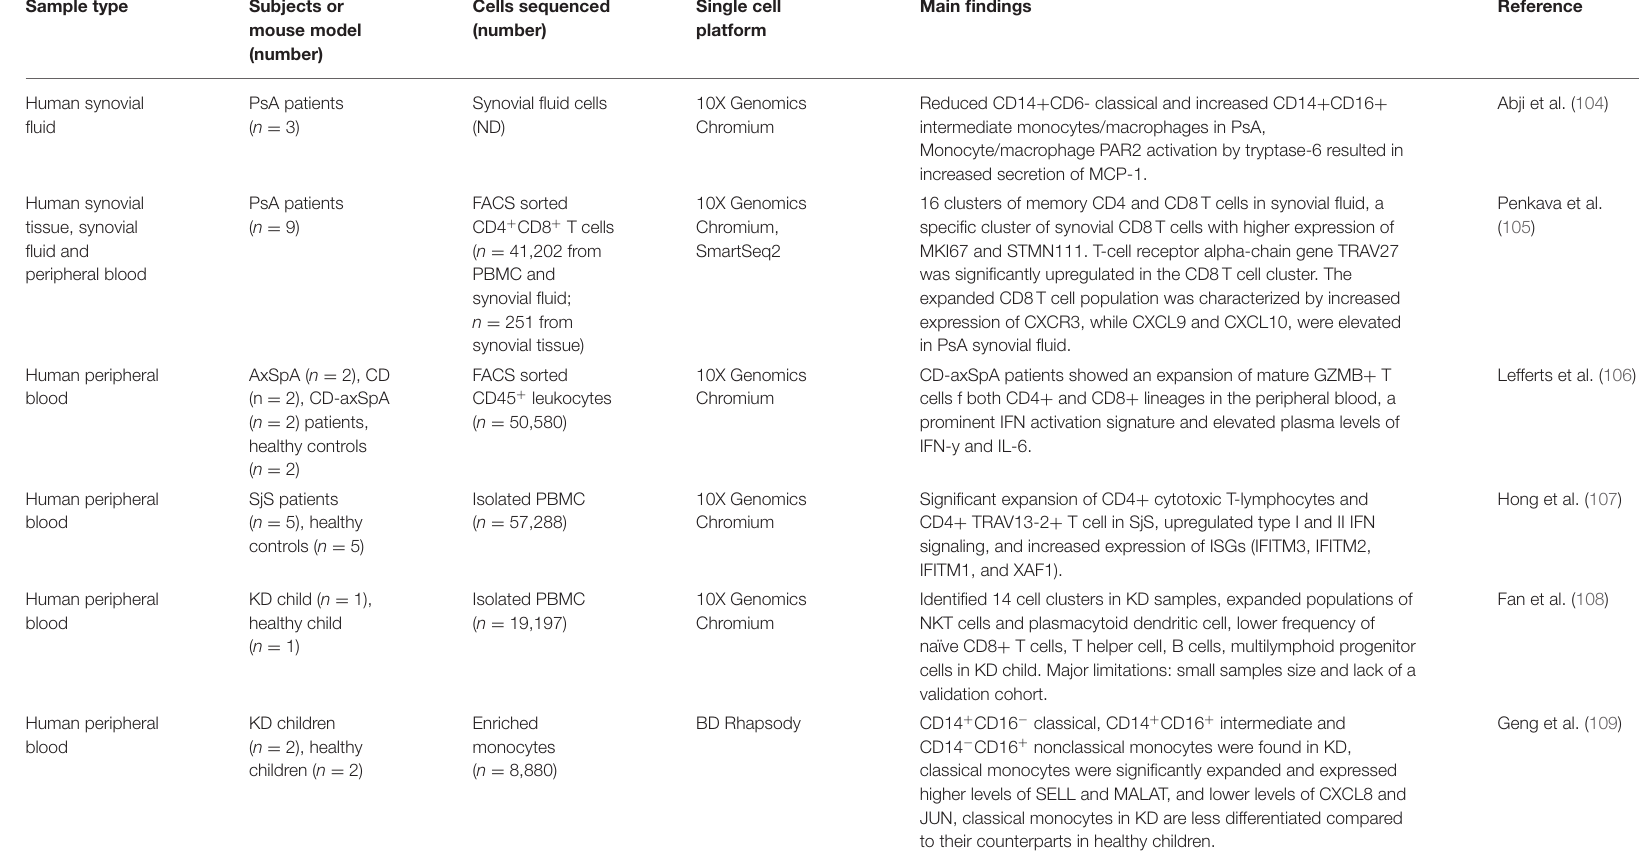
TABLE 4 | Application of scRNA-seq technology in PsA, AxSpA, SjS and KD. Sample